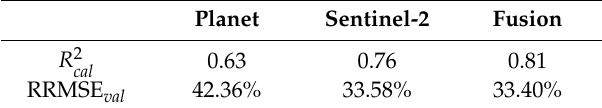
Table 7. Values for R 2